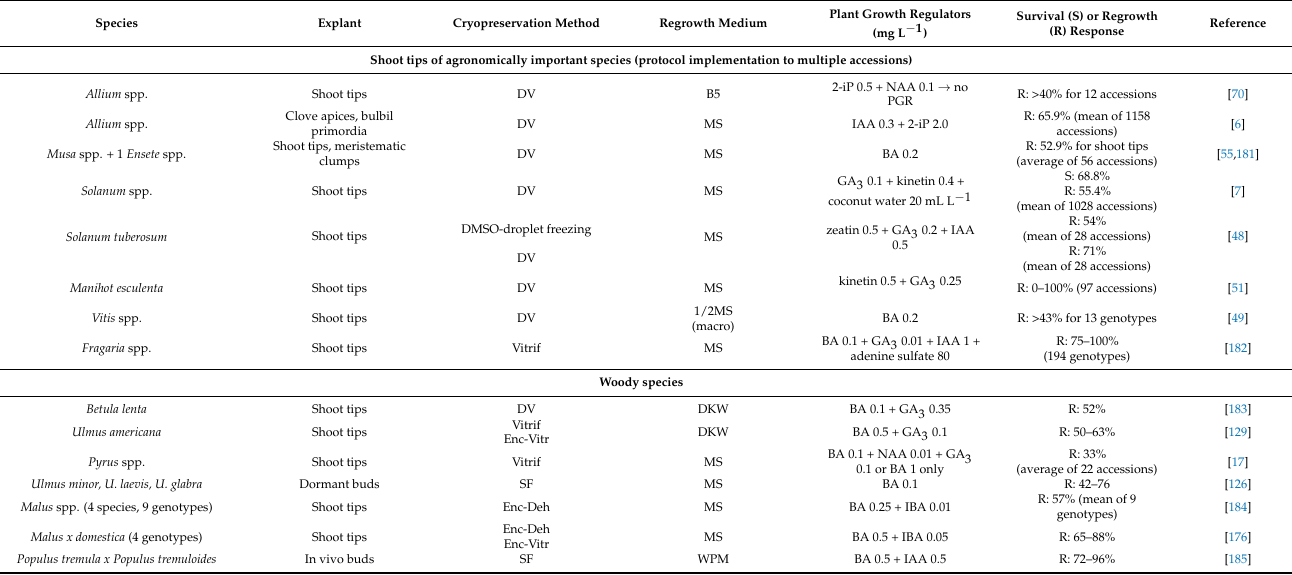
Table 3. Examples of plant growth regulators used at the recovery step during cryopreservation of shoot tips of forest and fruit trees and agronomically important species in world genebanks.